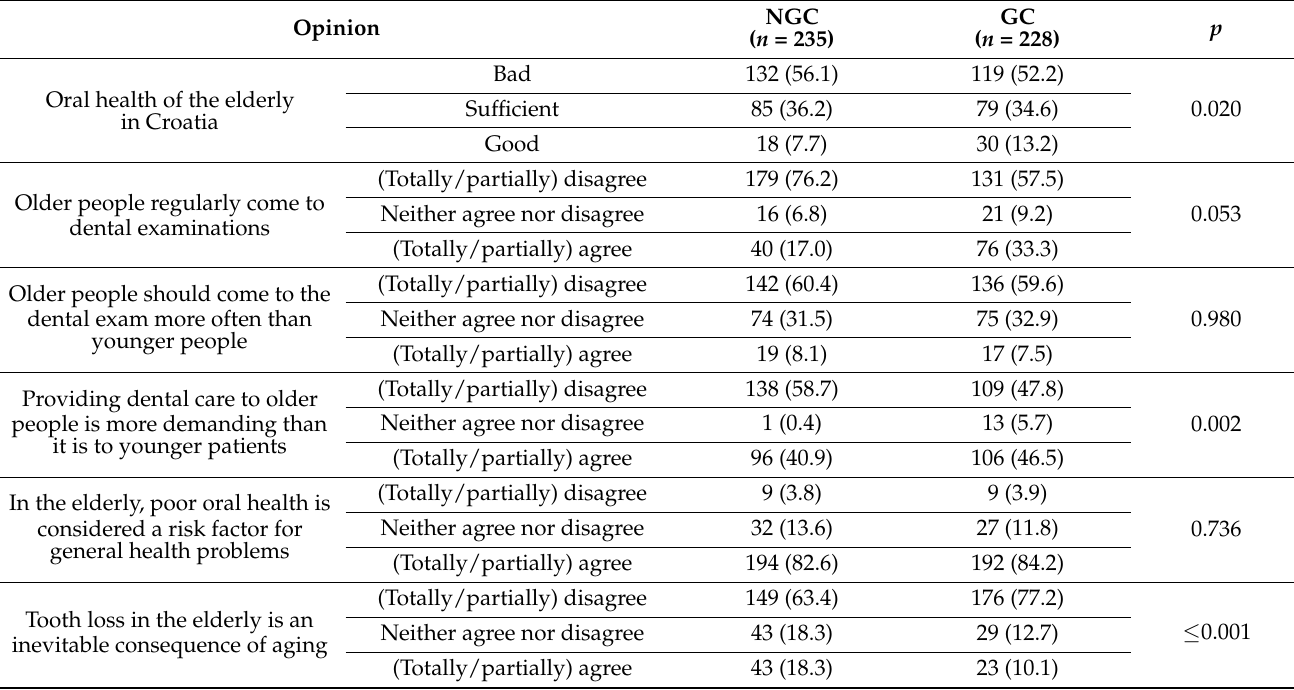
Table 2. Respondents’ opinion on the oral health of the elderly ( n =